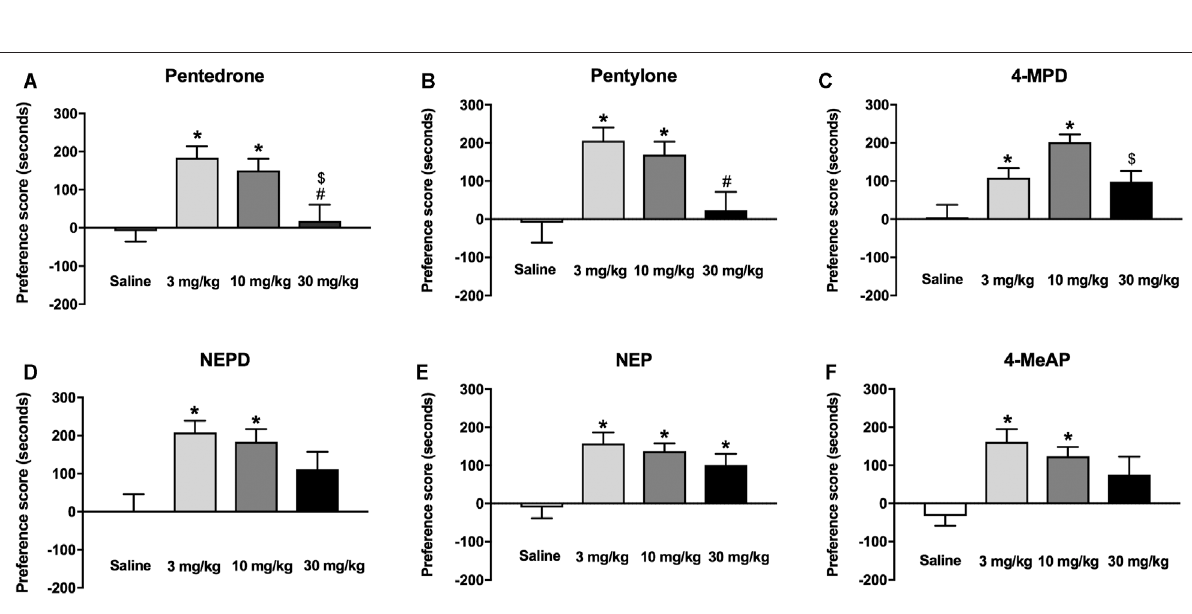
Frontiers in Pharmacology |